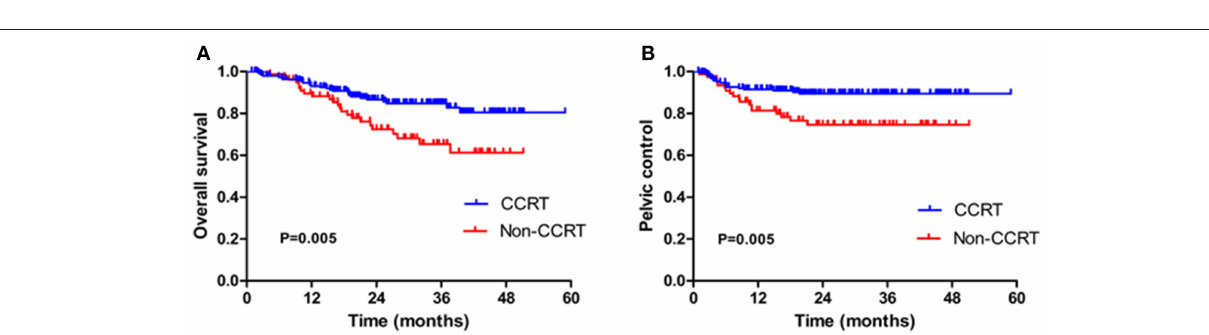
acute grade 3 and 4 leukopenia were 8.5 and 0.6%.